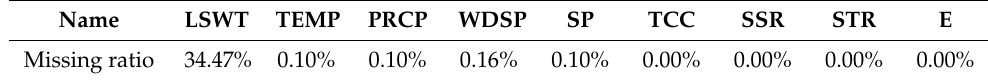
Table 3. The ratio of missing values in